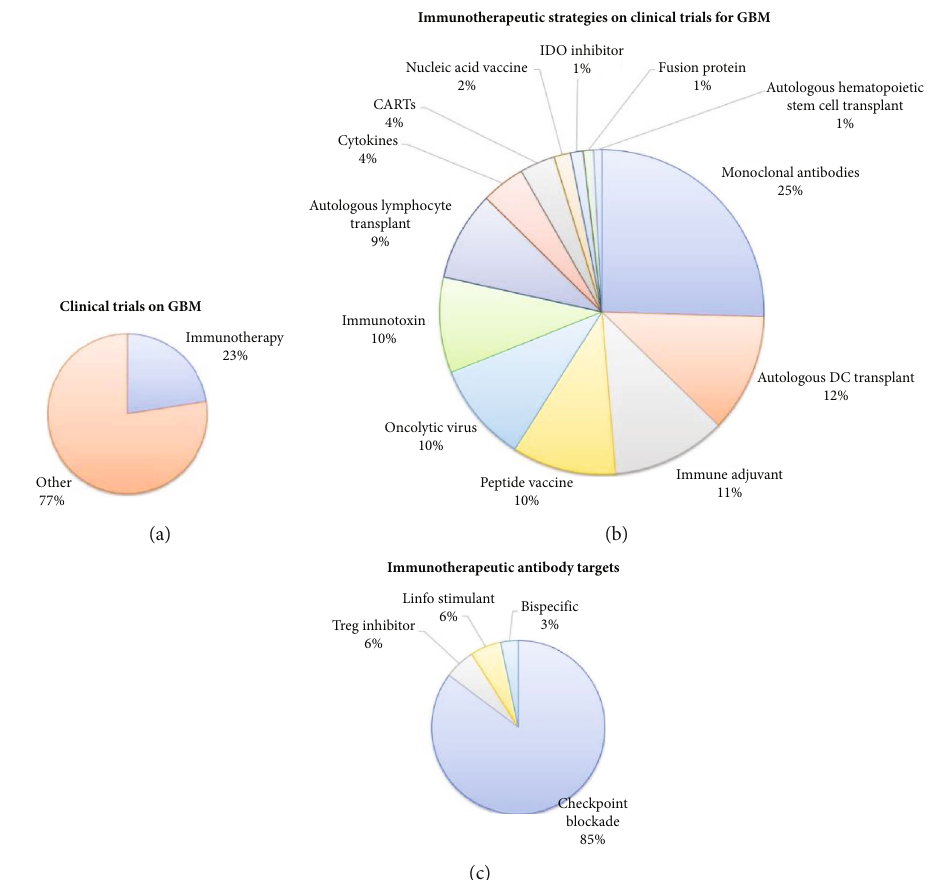
Figure 1: Targets of clinical trials for